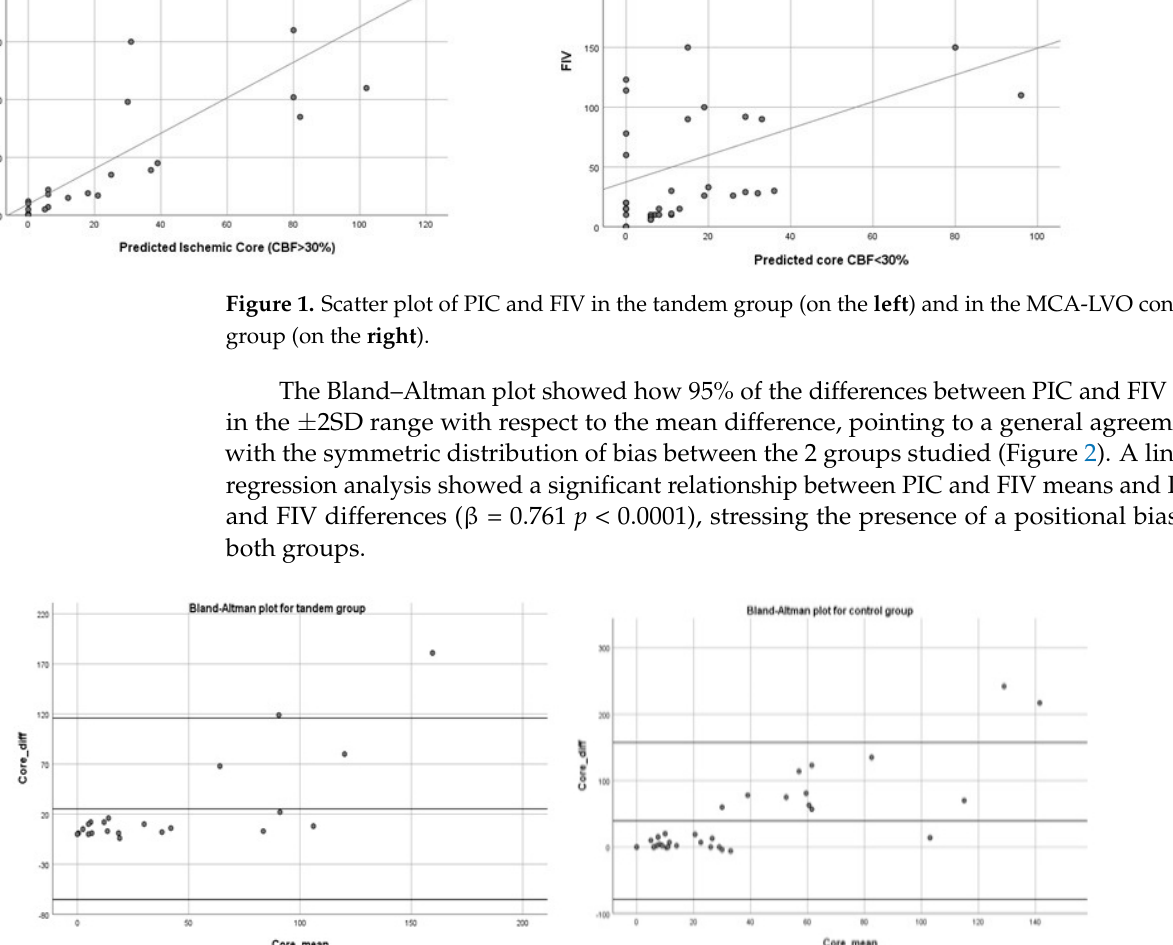
Table 4. Comparisons between groups for perfusion parameters—secondary analysis.